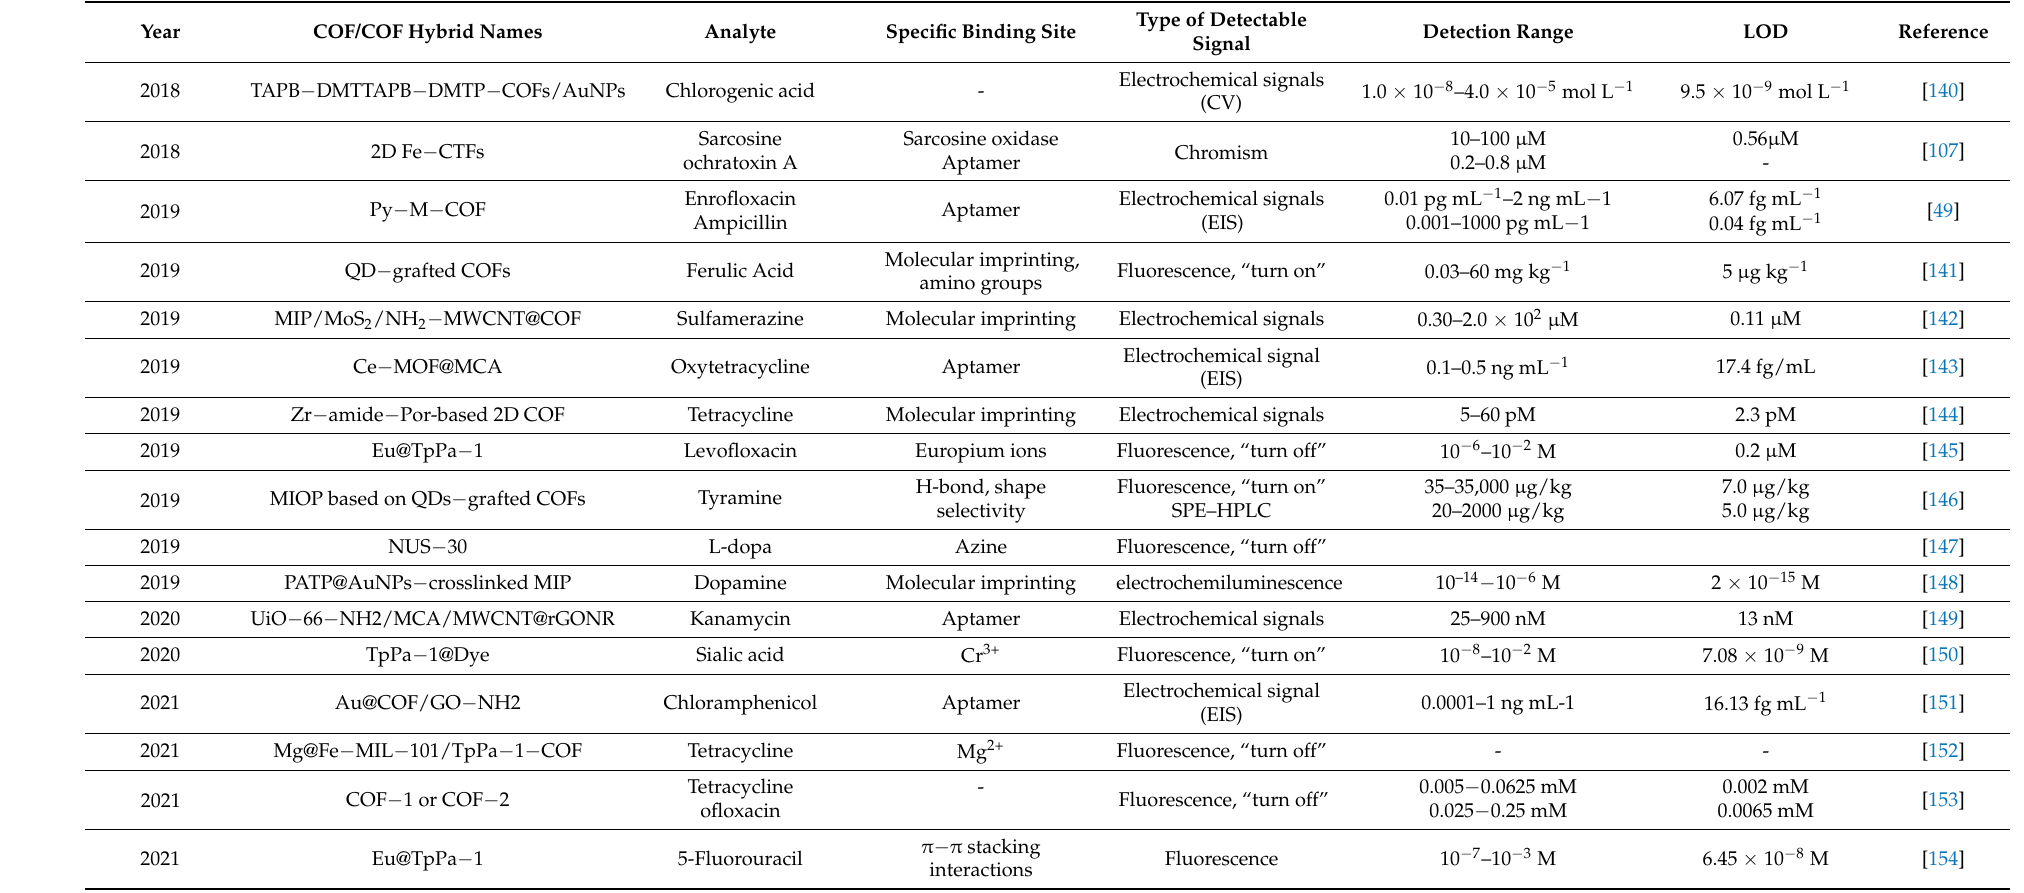
Table 7. COF-based detection of drugs, insecticides and